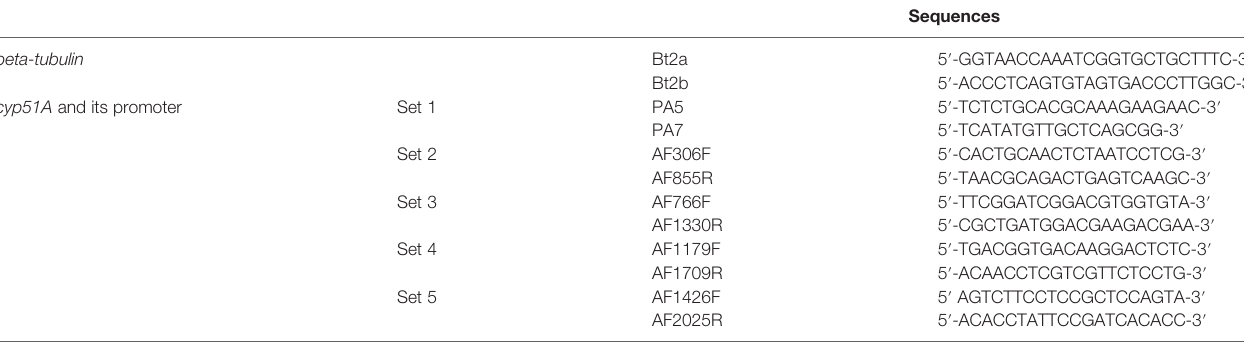
TABLE 1 | Sequences of primers used for beta-tubulin and cyp51A and its